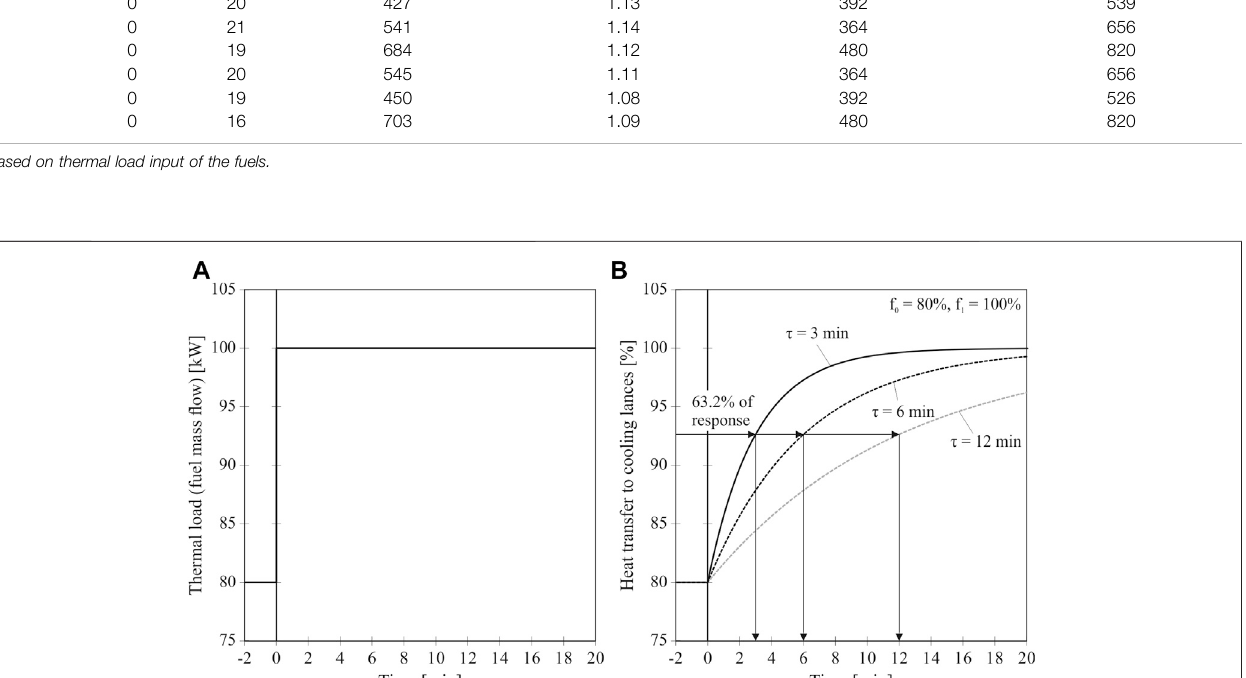
Frontiers in Energy Research |